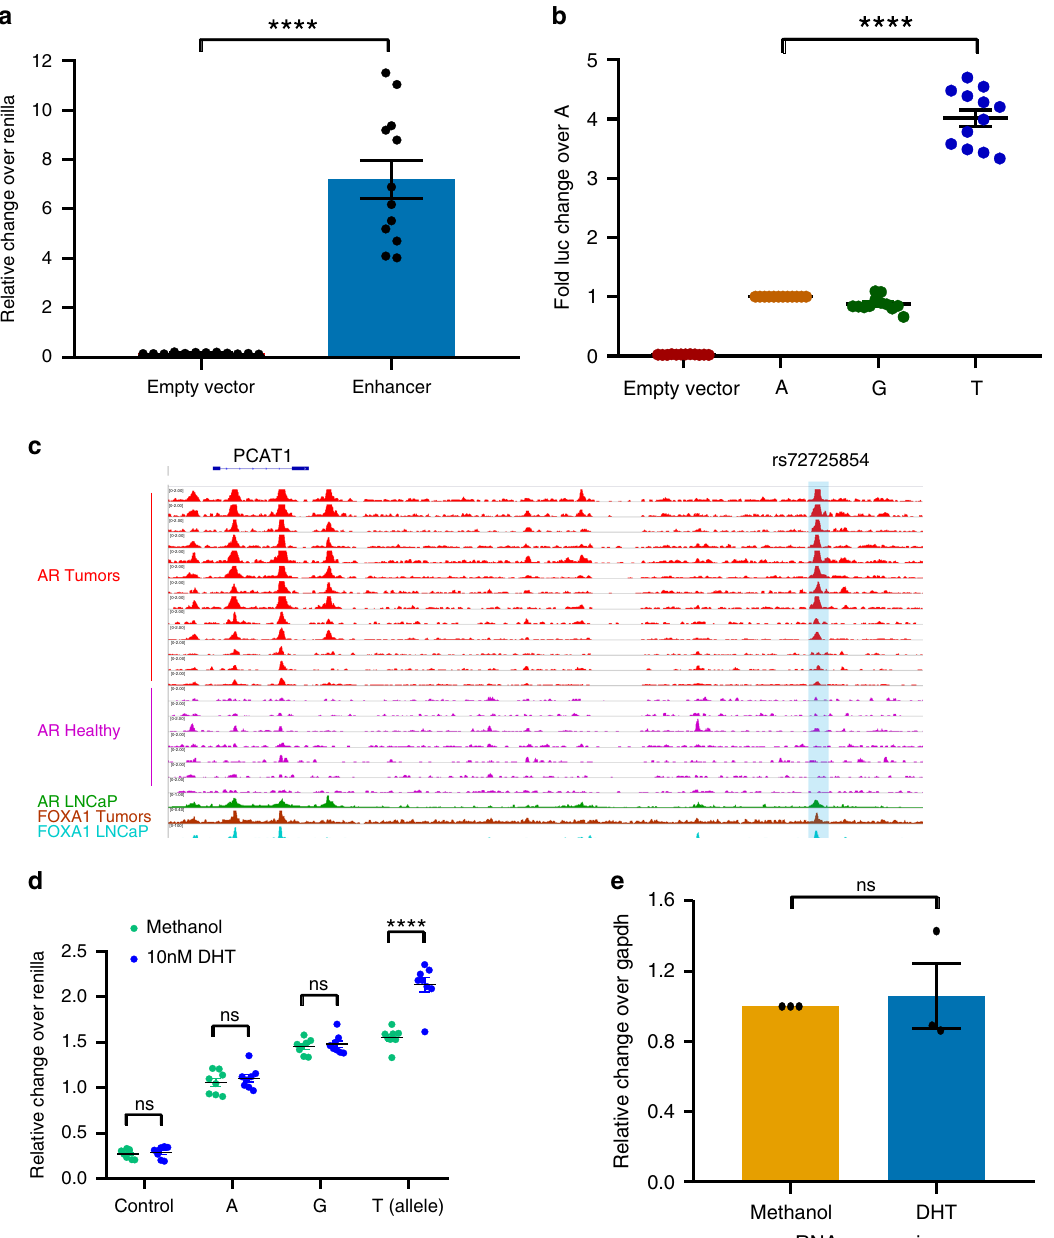
Fig. 2 Risk allele sensitizes the enhancer to androgens. a The graph depicts relative luciferase activity over Renilla for the empty plasmid and the plasmid harboring the rs72725854 enhancer region in LNCaP cells. b The graph depicts the fold change in reporter activity of empty plasmid, “ G ” and “ T ” allele over “ A ” allele in LNCaP cells. Error bars denote SEM from multiple biological replicates ( n > 3) in a and b . c UCSC genome browser snapshot around the rs72725854 region with ChIP-seq tracks for AR in tumors, healthy individuals and LNCaP cells and, FOXA1 in tumors and LNCaP cells. d The graph depicts the relative change over Renilla for the empty plasmid and plasmids harboring the different alleles “ A ” , “ G ” , and “ T ” of rs72725854 enhancer in LNCaP cells grown in charcoal stripped media for three days including the treatment with methanol or 10 nM DHT for 16 h. Error bars denote SEM from multiple biological replicates ( n > 3). e q-RT PCR analysis showing eRNA expression at rs72725854-harboring enhancer upon 10 nM DHT treatment for 16 h in LNCaP cells. Error bars denote SEM from three biological replicates. p -values were calculated by Student ’ s two-tailed unpaired t -test in a , b , d , and e **** p < 0.0001, ns p > 0.05. Source data are provided as a Source Data fi